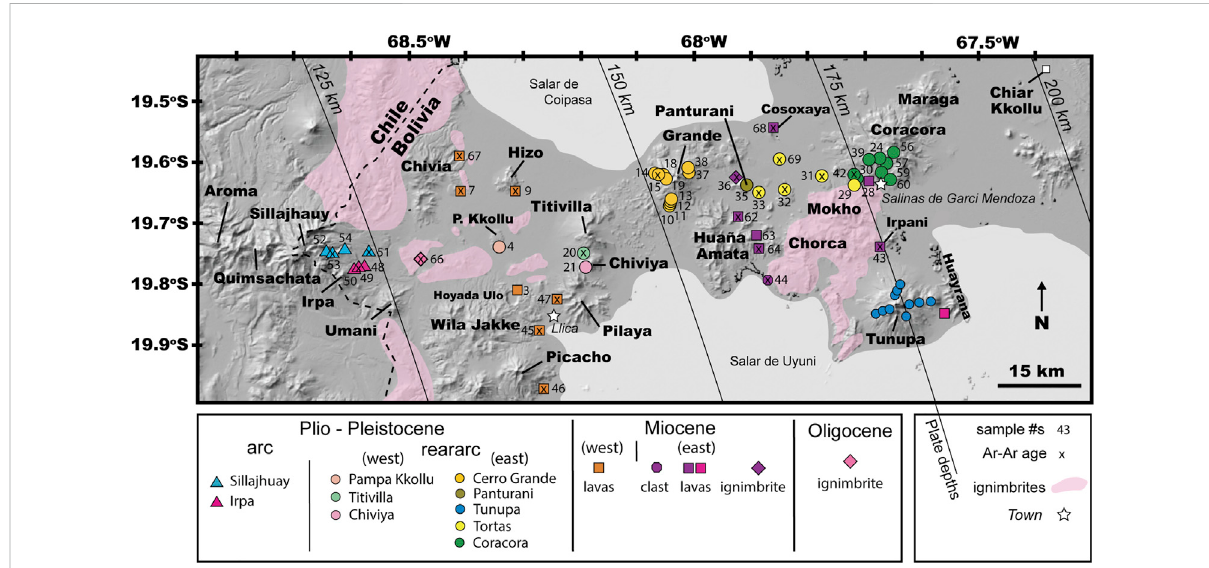
FIGURE 3 LocationsofsamplecollectionsitesshownonadigitaltopographicmapoftheIntersalarRange(SRTM90data).Allsamplesshownarefromthis study except for those of Tunupaand Huayrana (Salisbury et al., 2015) and Chiar Kkollu (Davidson and deSilva, 1995;Hoke and Lamb, 2007). Whole- rock geochemical data analyzed for all newly collected samples, with 40 Ar/ 39 Ar age determinations marked with x. Triangles indicate samples from arc volcanoes, circles are reararc Pliocene-Pleistocene lavas, squares are Miocene lavas, octagon is Miocene breccia clast, and diamonds are pyroclastic deposits. Ages of undated samples are based on stratigraphic relations with dated samples and/or geologic mapping by Leytón and Jurado(1995).ForPlio-Pleistocenecenters,colorsrepresentsamplesfromindividualvolcaniccenters.ForMiocenecenters,colorsindicatewestern and eastern groups. Symbol shapes and colors are consistent in all fi gures. Plate depths from Cahill and Isacks